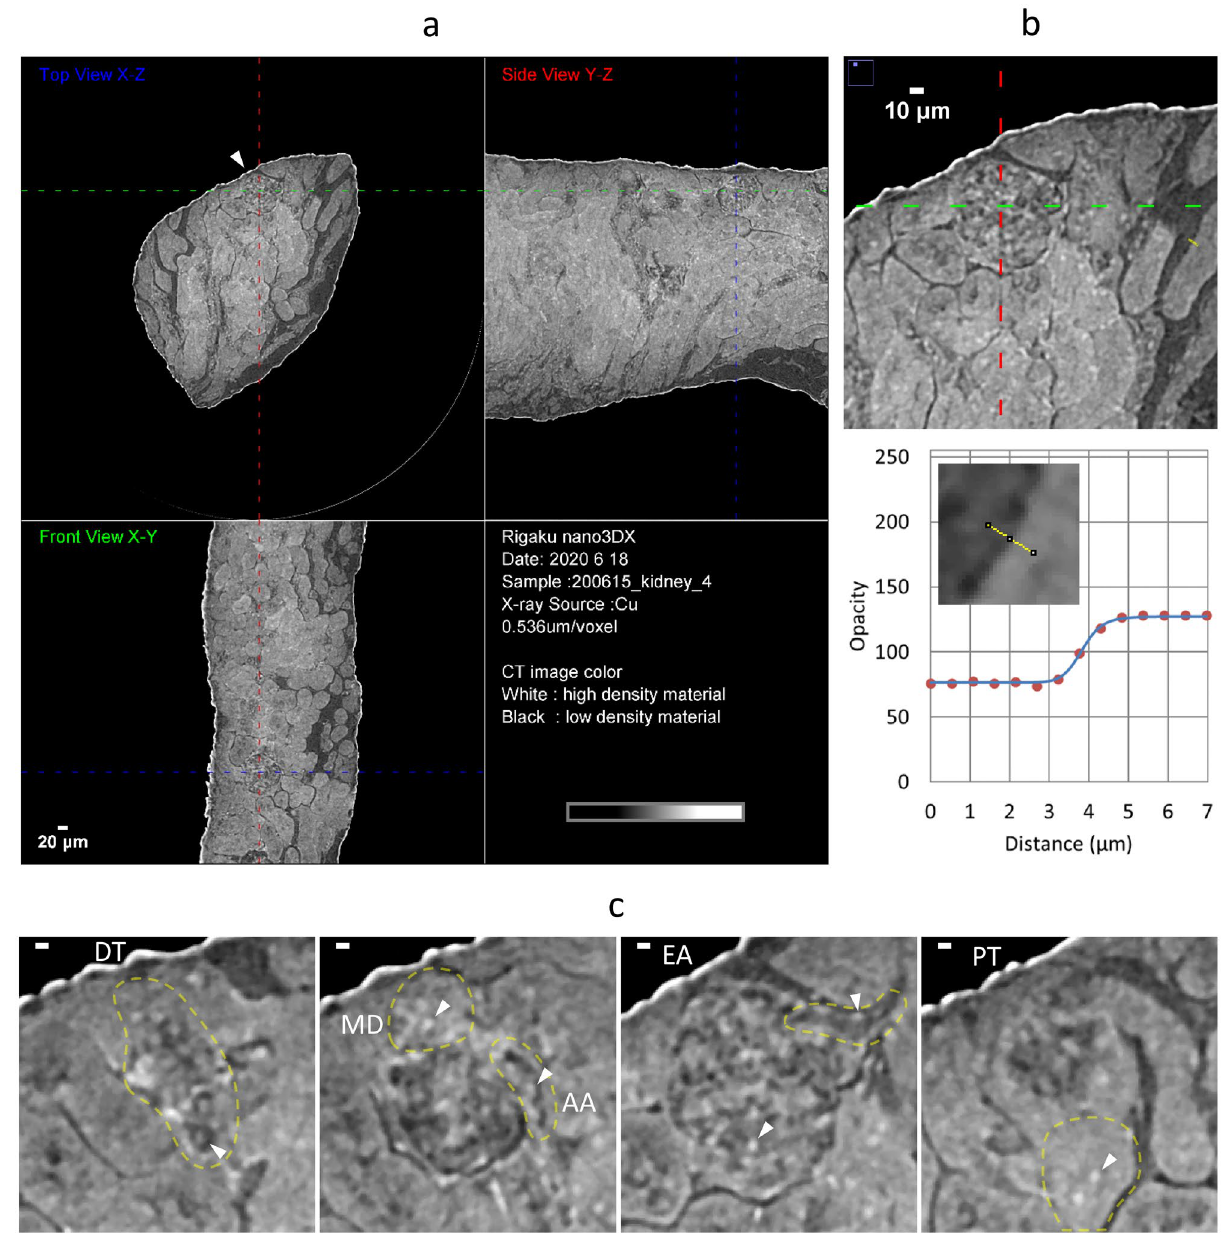
Figure 3. CT images at cellular-level resolution from laboratory-based X-ray microscopy with paraffin- mediated contrast enhancement. ( a ) Orthogonal CT slices from three different perspectives. These images are derived from the sample shown in Fig. 2a and in Table 1 (normal mouse). Conditions for the data collection are described in Methods. A renal corpuscle is indicated by an arrowhead. ( b ) Measurement of SBE. Magnified part of ( a ) around the renal corpuscle is represented with an opacity profile along the yellow line (about 7 μm). A further magnified part of CT slice around the yellow line is shown as an inset of the line profile. In the profile, red circles represent observed values of opacity. Obtained SBE from the curve fitting (blue line) was 0.56 μm. ( c ) Parts of renal corpuscle. Presented is the single renal corpuscle marked in ( a ). Magnified CT slices are shown from left to right around distal tubule (DT; section 826th/1222), afferent arteriole (AA; section 854th/1222) with macula densa (MD), efferent arteriole (EA; section 905th/1222), and proximal tubule (PT; section 969th/1222). Relevant parts are encircled by yellow broken lines. Putative nuclei are visible in all parts as white dots with sizes in the range of 3–5 μm; some of them were indicated by arrowheads. Scale bars: 5